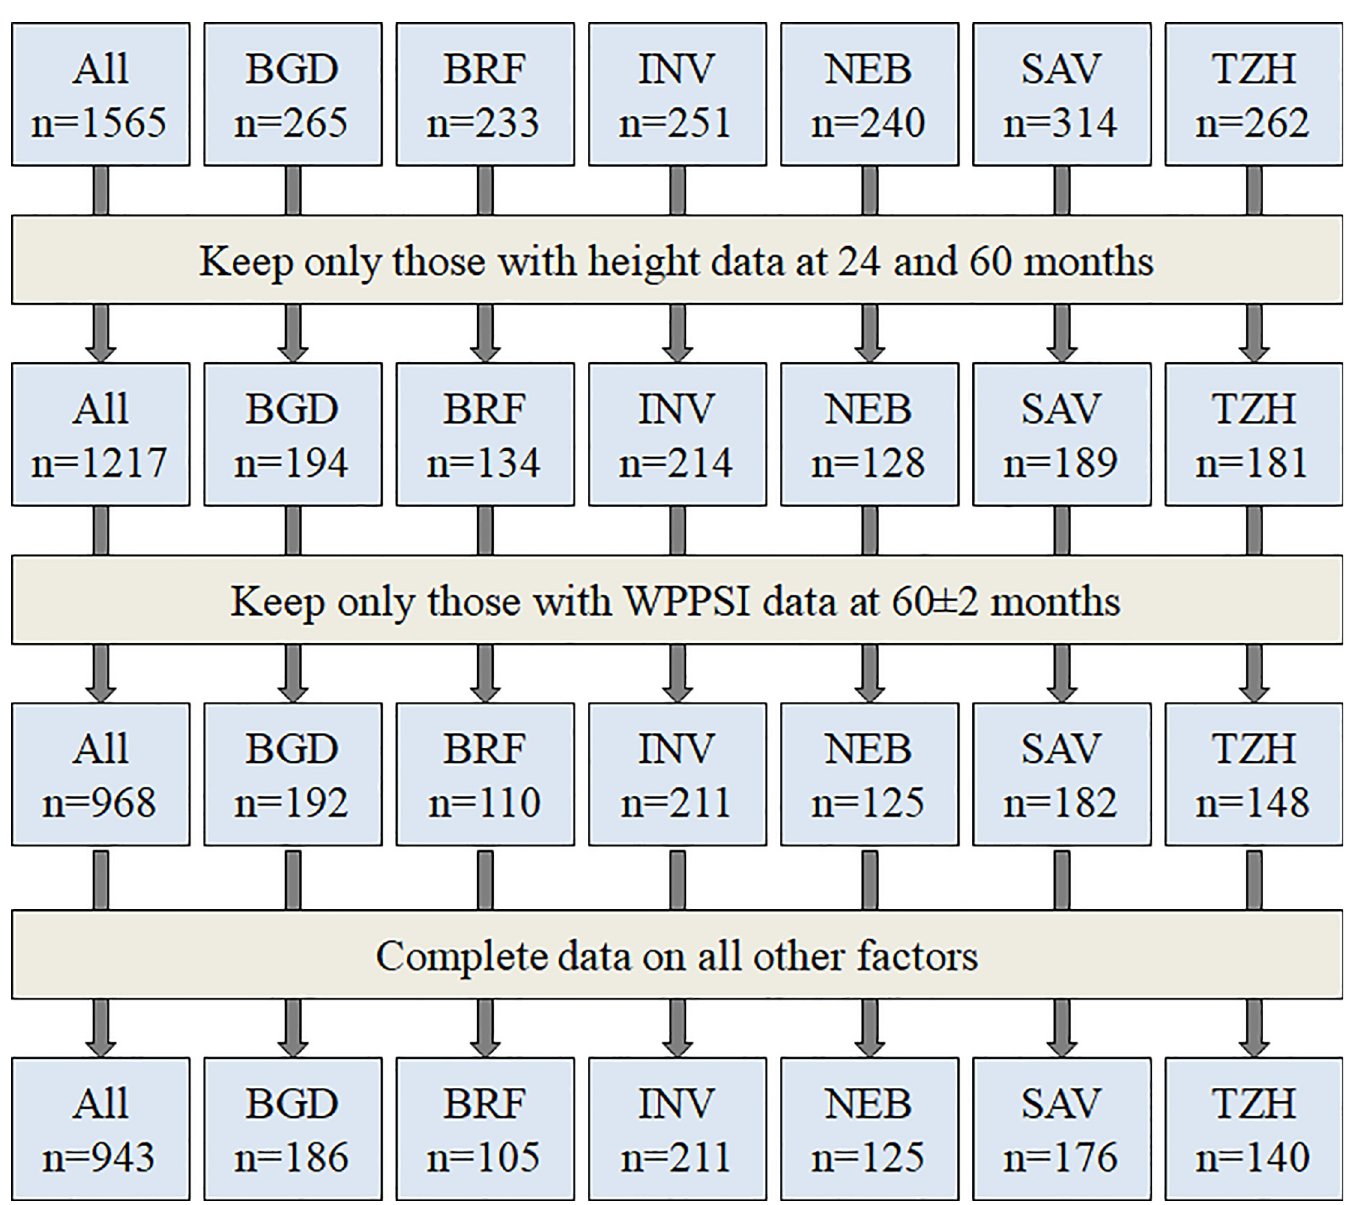
Fig 1. MAL-ED cohort profile of children who were retained in the analysis. [Sites: BGD: Bangladesh–Dhaka; BRF: Brazil–Fortaleza; INV: India–Vellore; NEB: Nepal–Bhaktapur; SAV: South Africa–Venda; TZH: Tanzania–Haydom].